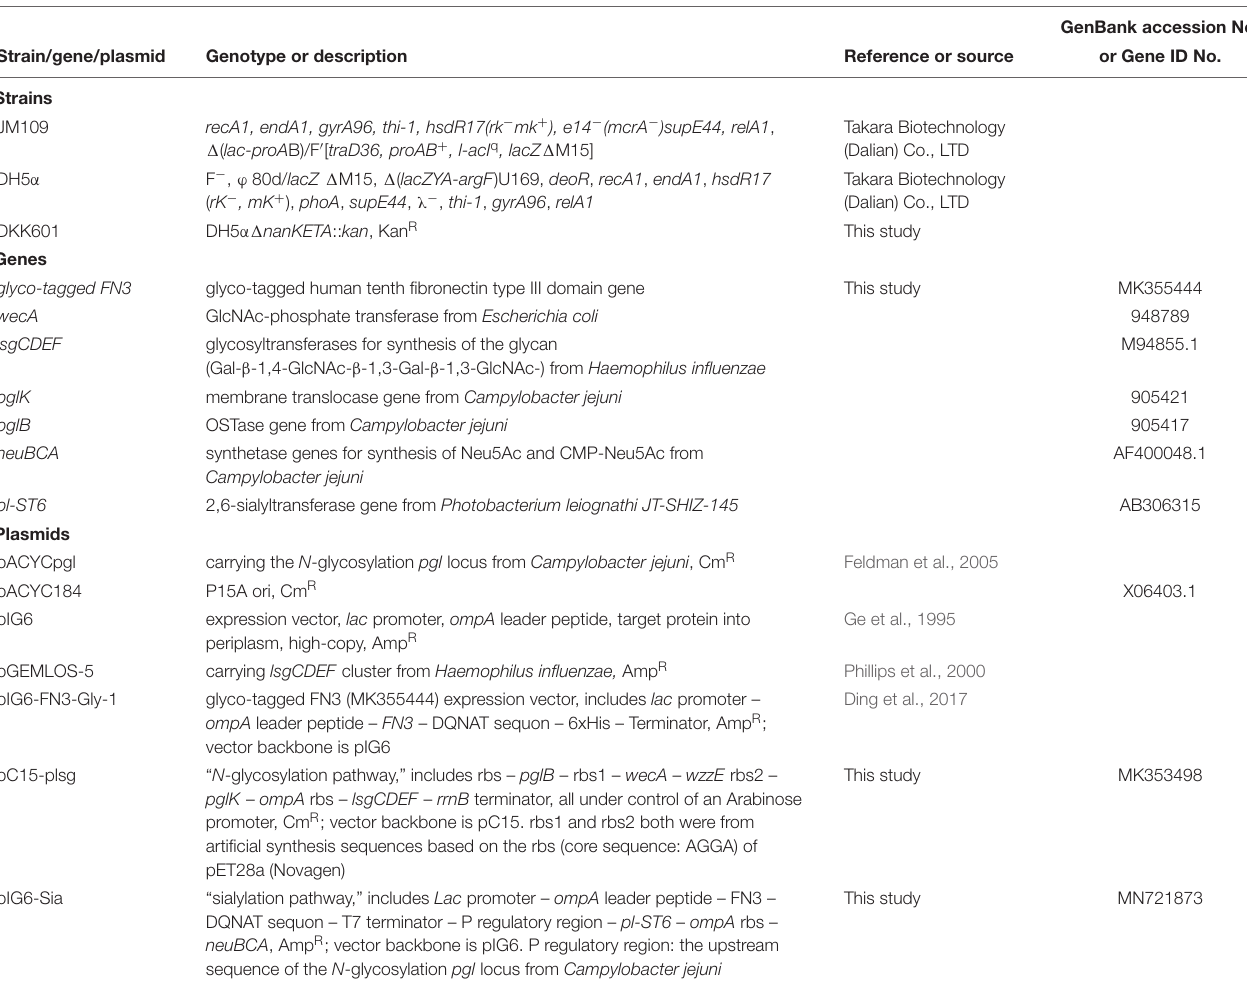
TABLE 1 | Key strains, genes and plasmids used in this